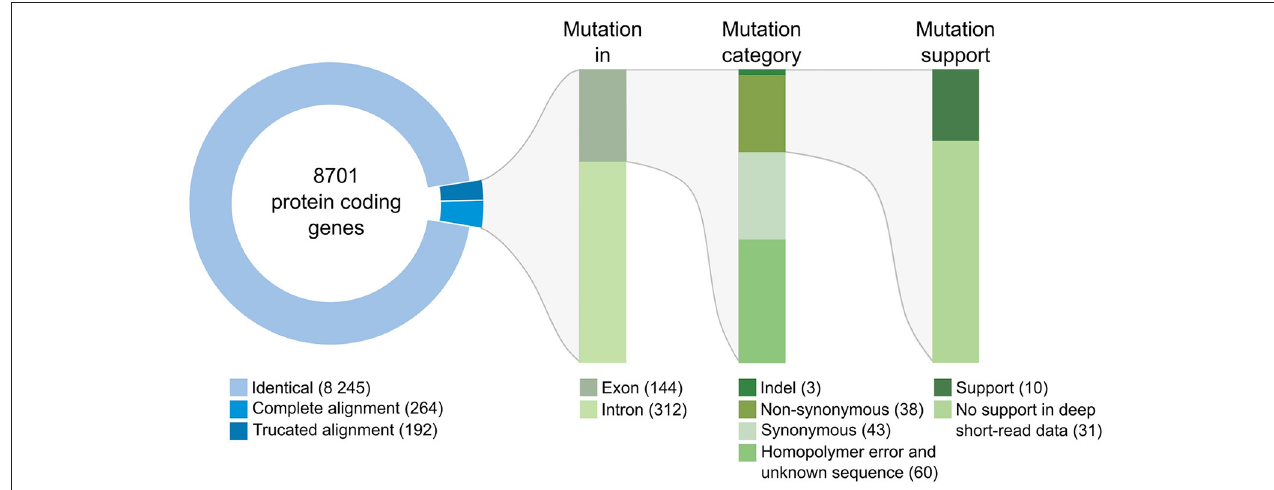
FIGURE 3 | Classification of mutations identified between the genomes of the Swe strains. The overview includes the number of genes and mutations identified at each step of the workflow (see section Methods for details). Mutations identified in introns were individually examined; none affected splice donor or acceptor sites.